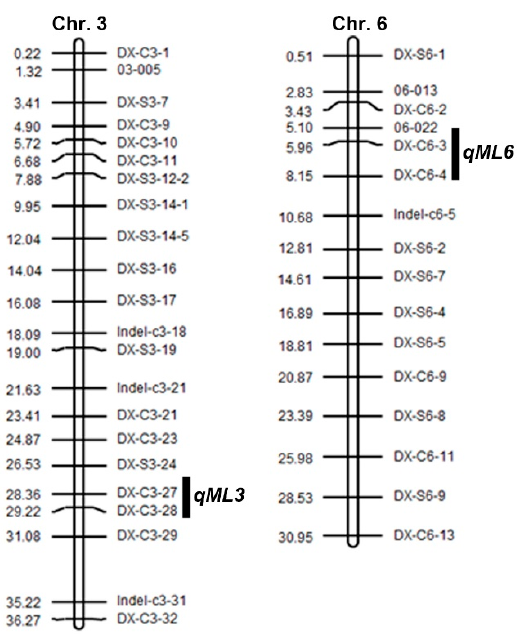
Figure 2. Chromosomal locations of QTLs for mesocotyl length in the CSSLs. The abbreviations for the QTLs are defined in Table 1. The position of each marker is based on the physical distance shown to the left of each chromosome, and the molecular marker is shown on the right. The positions of the two significant QTLs on chromosomes 3 and 6 are illustrated by solid black bars next to the chromosomes. Table 1. QTLs for mesocotyl length detected in the CSSLs.